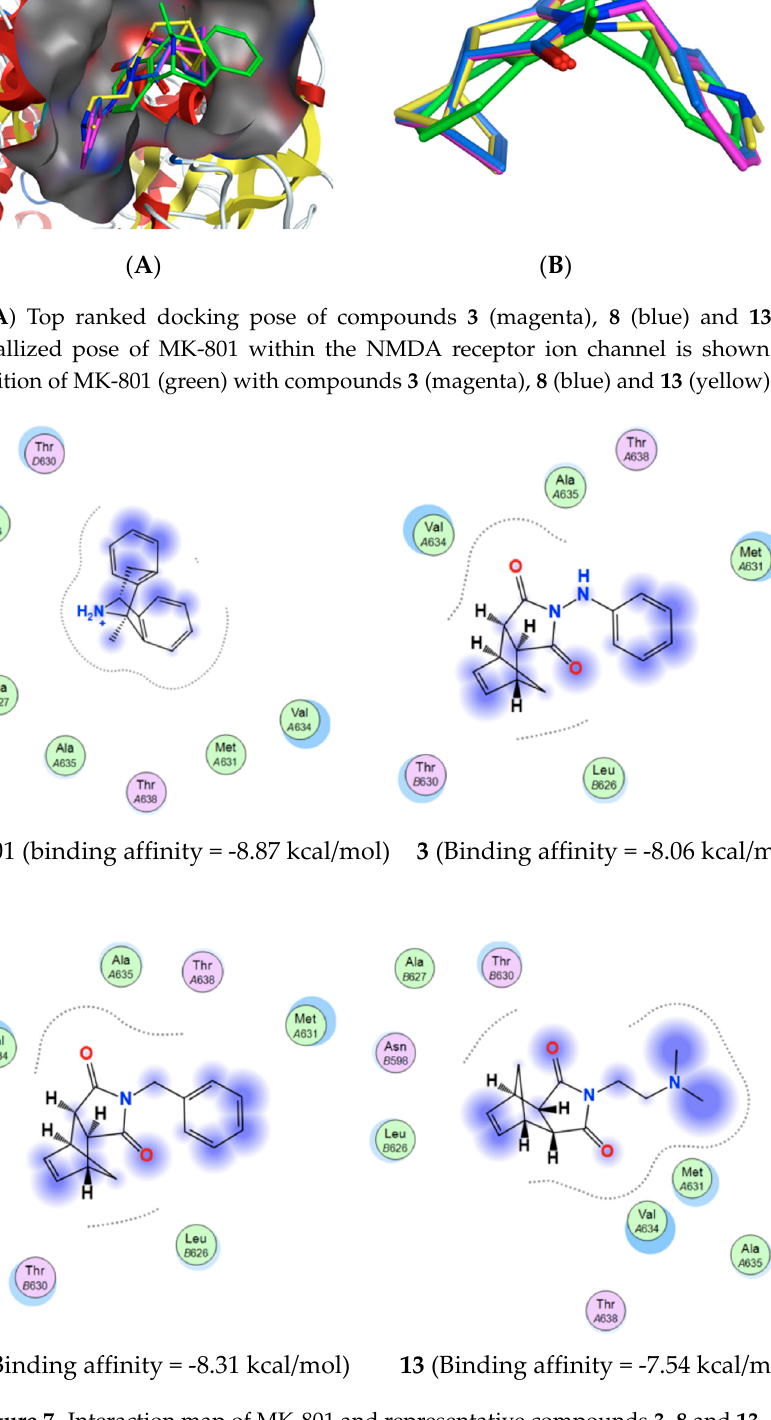
Figure 7. Interaction map of MK-801 and representative compounds 3 , 8 and 13 .